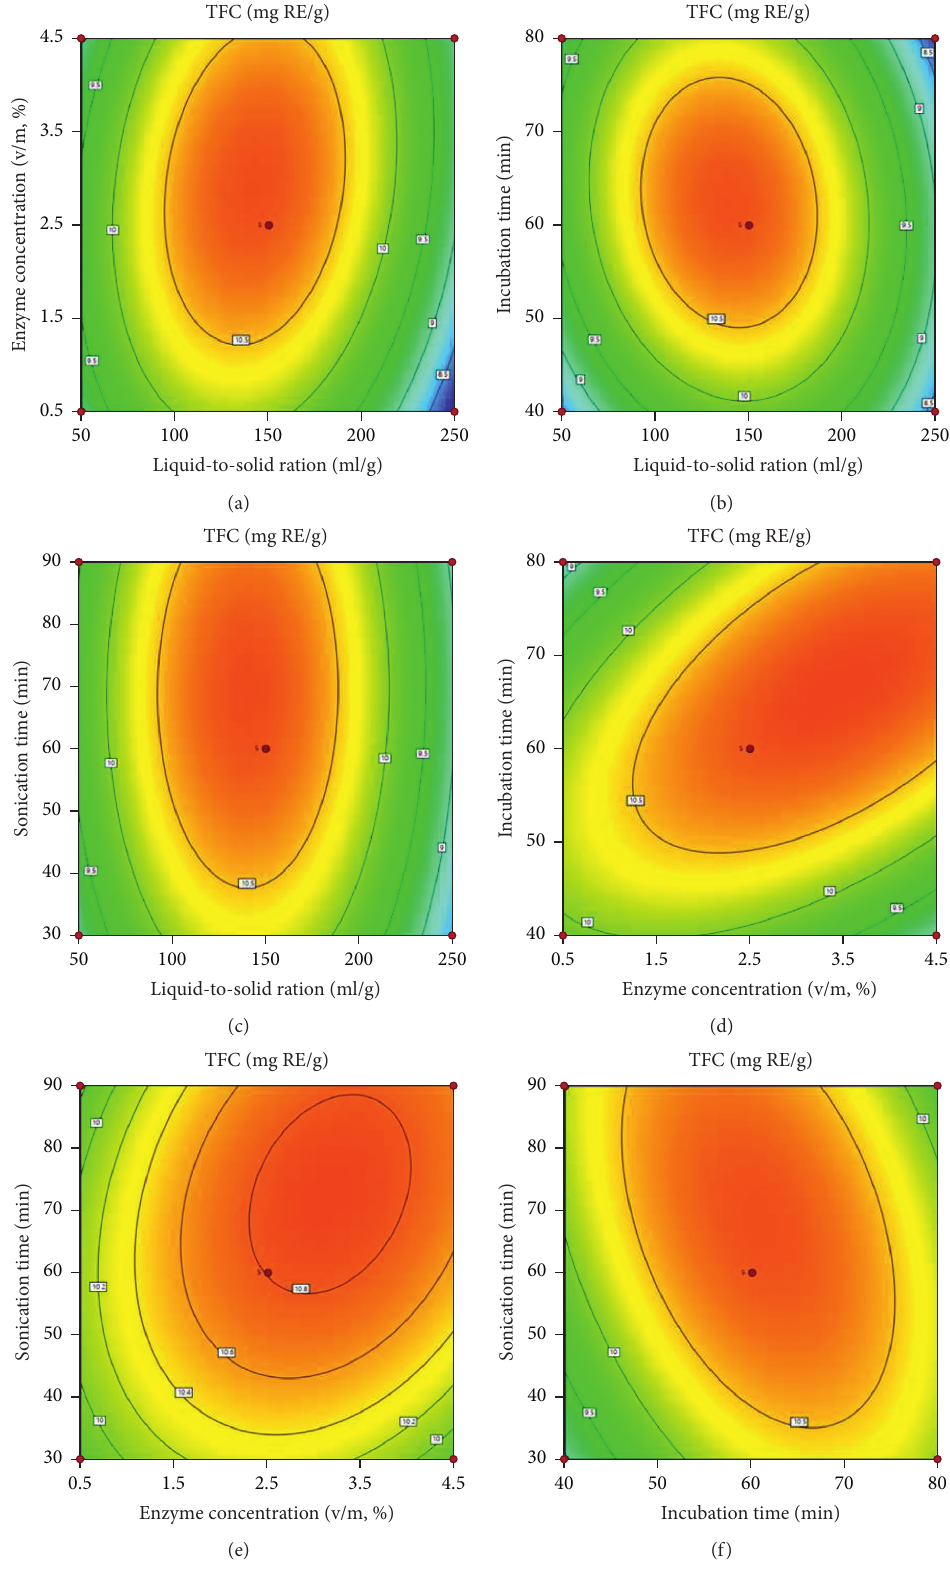
Figure 2: Contour plots (2D) showing the effect of different extraction parameters showing the effects of different extraction parameters on extraction yield of flavonoids from Da Xanh pomelo peel (a) at varying liquid to solid ratio and enzyme concentration, (b) at varying liquid to solid ratio and incubation time, (c) at varying liquid to solid ratio and ultrasonic time, (d) at varying enzyme concentration and incubation time, (e) at varying enzyme concentration and ultrasonic time, and (f) at varying incubation time and ultrasonic